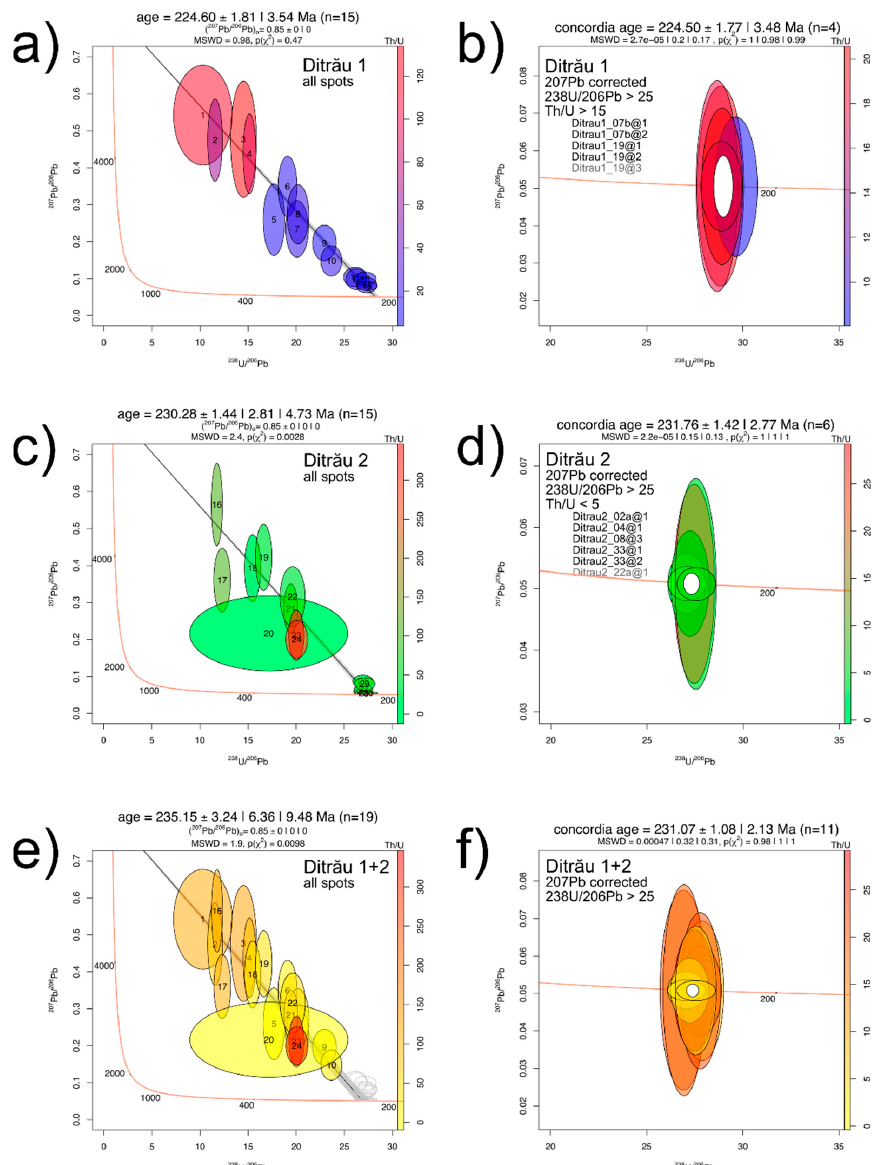
Figure 7. Zircon U-Pb Tera–Wasserburg concordia plots. ( a ) Ditr ă u 1 (L ă zarea suite), all data points. A forced regression through 207 Pb/ 206 Pb = 0.851 results in a lower intercept age of 224.60 ± 3.54 Ma. ( b ) Ditr ă u 1 (L ă zarea suite), 5 data points with 238 U/ 206 Pb > 25, 206 Pb/ 204 Pb > 200, and 207 Pb corrected define a concordia age of 224.50 ± 3.48 Ma. ( c ) Ditr ă u 2 (Ghidu ţ suite), all data points. A forced regression through 207 Pb/ 206 Pb = 0.851 results in a lower intercept age of 230.28 ± 2.81 Ma. ( d ) Ditr ă u 2 (Ghidu ţ suite), 5 data points with 238 U/ 206 Pb > 25 and 206 Pb/ 204 Pb > 400; ( e , f ) as above but combining the data from Ditr ă u 1 and Ditr ă u 2. A forced regression through 207 Pb/ 206 Pb = 0.851 results in a lower intercept age of 235.15 ± 6.36 Ma. All data points with 238 U/ 206 Pb > 25, 206 Pb/ 204 Pb > 400, and 207 Pb corrected define a concordia age of 231.07 ± 2.13 Ma. See text for detailed discussion.